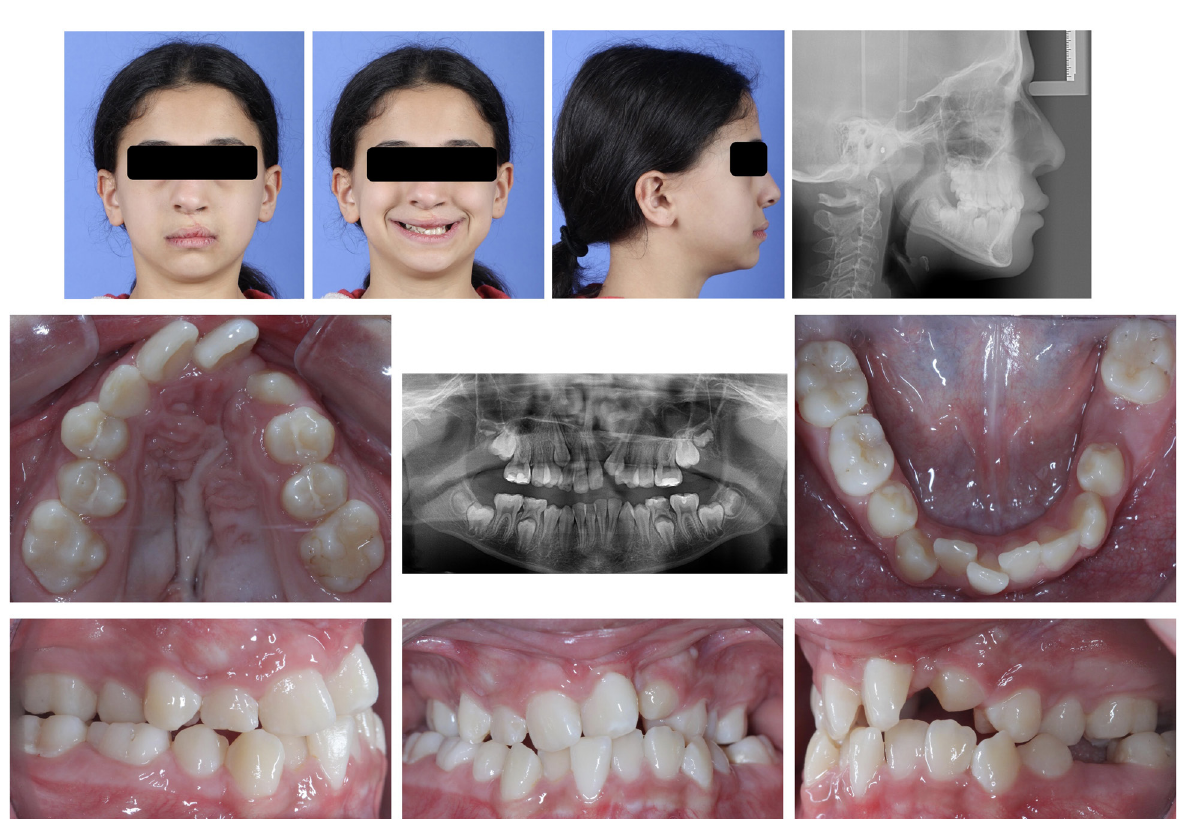
Figure 4. Photographs of the patient before and during orthodontic treatment in the mixed dentition period. Pre-treatment intraoral and extraoral profile and frontal photographs and panoramic and cephalometric